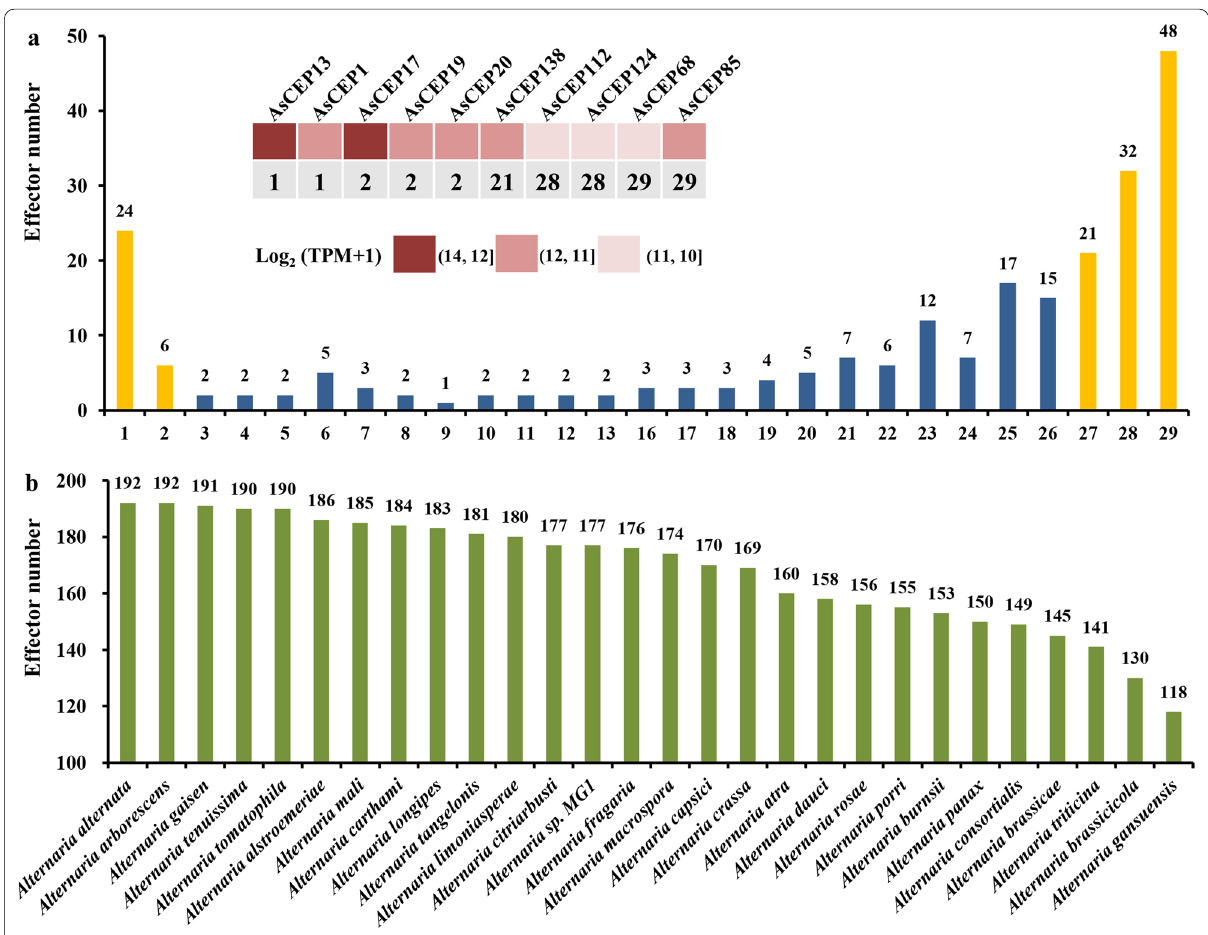
Fig. 2 Presence-and-absence variation (PAV) of AsCEPs genes in Alternaria species. a Histogram showing the counts of AsCEPs genes that were found in one to twenty-nine (X-axis) Alternaria species, and heatmap showing the conservation of the most highly expressed AsCEPs genes. Yellow columns represent effector genes found in more than 26 or less than three Alternaria species. The number indicated on each column represents the count of AsCEP genes. Colors in heatmap represent the Log 2 (TPM 1) values, and the numbers in grey boxes represent the number of Alternaria + species in which each gene was found. b The number of AsCEPs genes that have homologs in other Alternaria